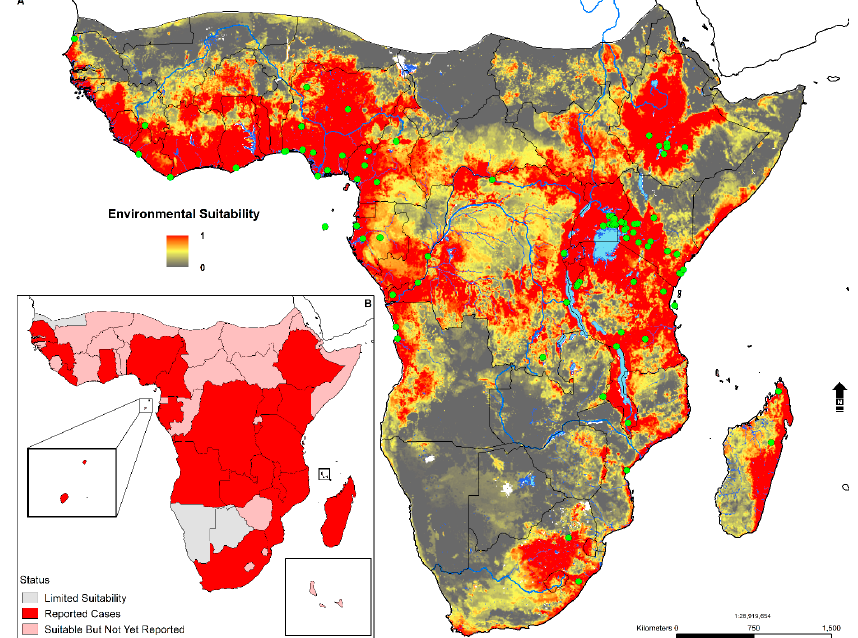
Figure 4. ( A ) Predicted distribution across sub-Saharan Africa (SSA). Probability of occurrence is provided on a scale from 0 (low probability) to 1 (high probability). Green dots correspond to occurrence locations (n = 86). (B) Status of occurrence reporting by country in SSA based on the weighted mean suitability model. Insets correspond to São Tomé and Príncipe and Comoros. Validation statistics (Figure 5) for the selected algorithms indicated good-strong performances. Overall, the random forest (RF) (AUC: 0.94; TSS: 0.86; KAPPA: 0.83), generalized boosted regression (GBM) (AUC: 0.86; TSS: 0.70; KAPPA: 0.68), and generalized linear models (GLM) (AUC: 0.83; TSS: 0.65; KAPPA: 0.63) outperformed both the GAM and Maxent (see Supplementary Materials: Table